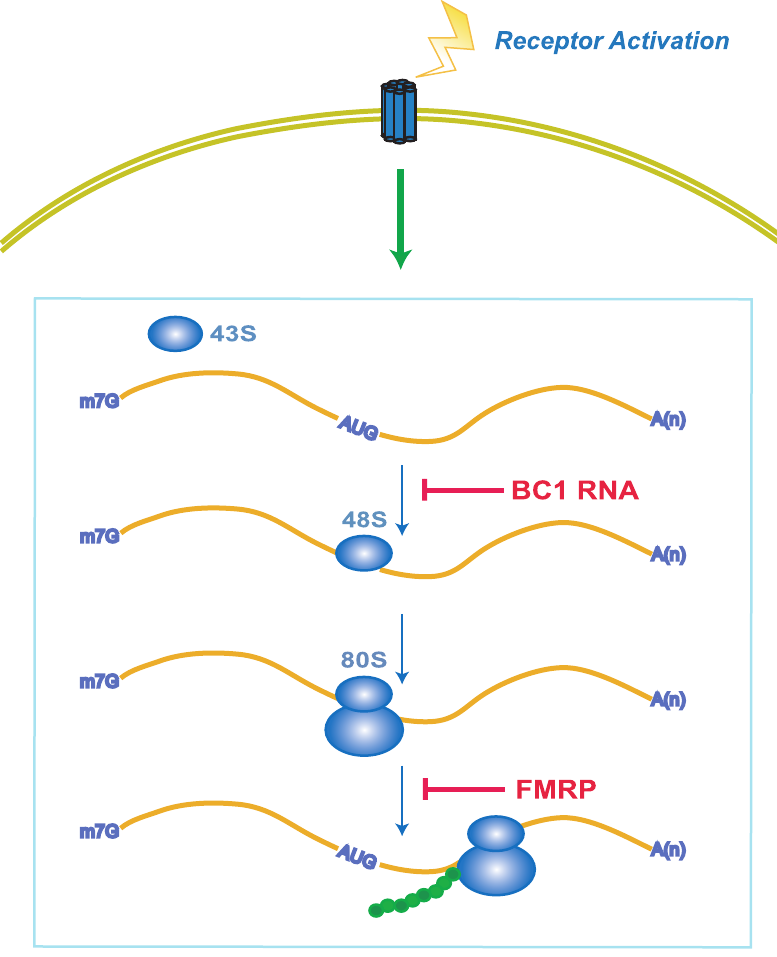
Figure 4. BC1 RNA and FMRP act as repressors on activity-stimulated translation. In this model, a balance of power is maintained in the postsynaptic translation pathway by the functional interplay between two opposing forces: (i) the stimulatory consequences of receptor activation, and (ii) translational repression by BC1 RNA and FMRP. It is suggested that BC1 RNA and FMRP, operating in series in the same translational pathway, target overlapping but non-identical sets of mRNAs. We posit that multiple repressors are needed at the synapse to ensure adequate stimulation- repression homeostasis and to allow for differential derepression options.